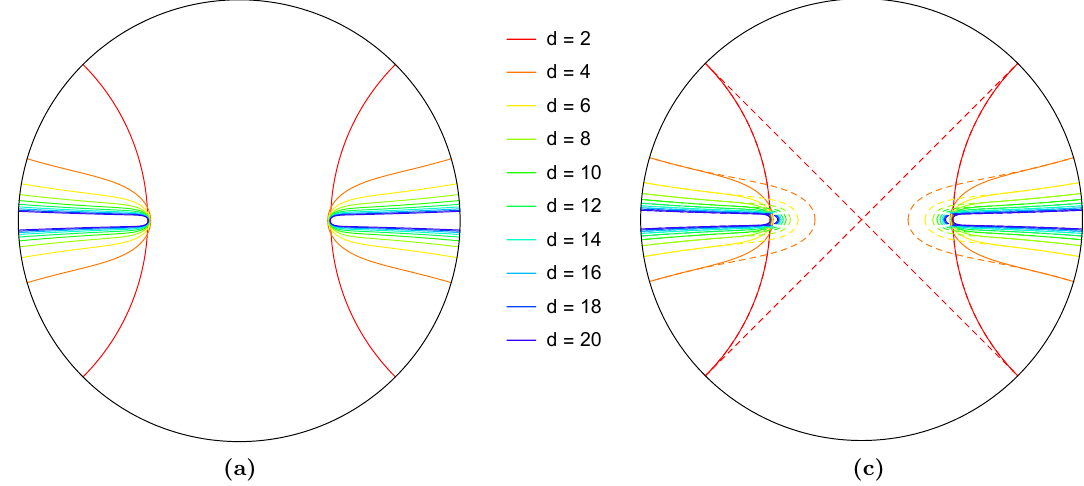
Figure 8 . (a) The tube-like minimal surfaces at the mutual information phase transition, projected down onto a single hyperbolic slice, for even dimensions in the range d = 2 through d = 20 : (b) The same surfaces together with their \inner branches" | the other set of tube-like surfaces with the same boundary conditions | plotted with dashed lines.